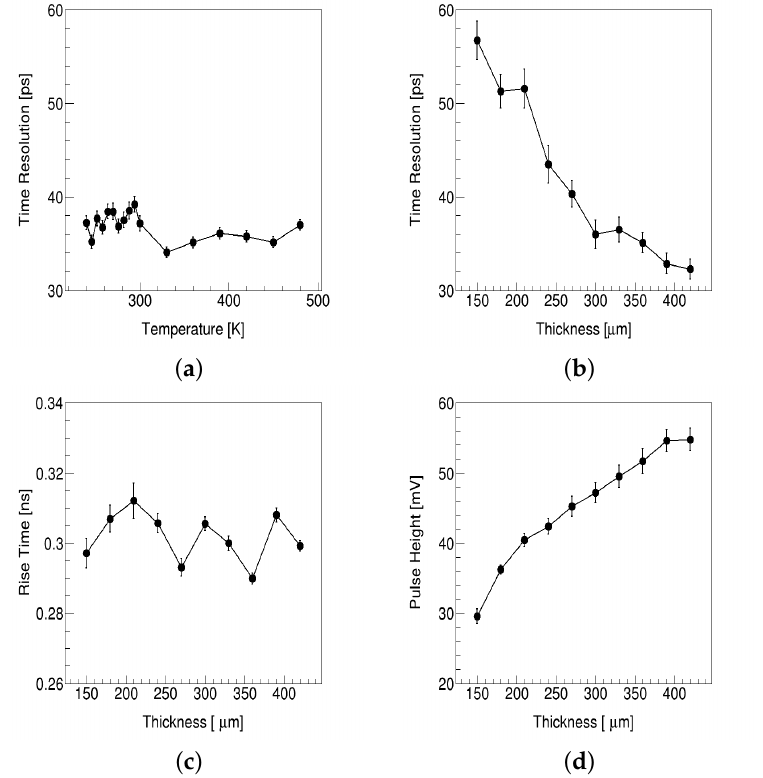
Figure 6. ( a ) Time resolution versus temperature. ( b ) Time resolution versus thickness. ( c ) Rise time versus thickness. ( d ) Pulse height versus